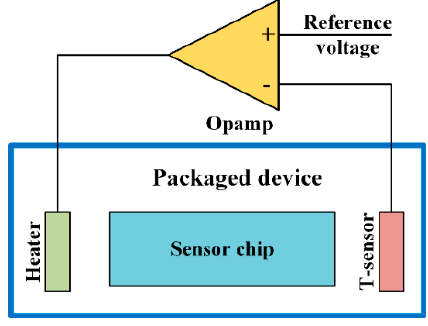
Figure 8. Schematic diagram of the temperature control system.